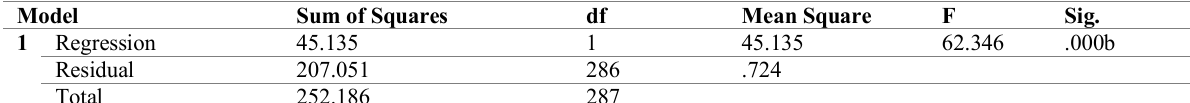
Table 3: ANOVA for Regression of LD against LGO